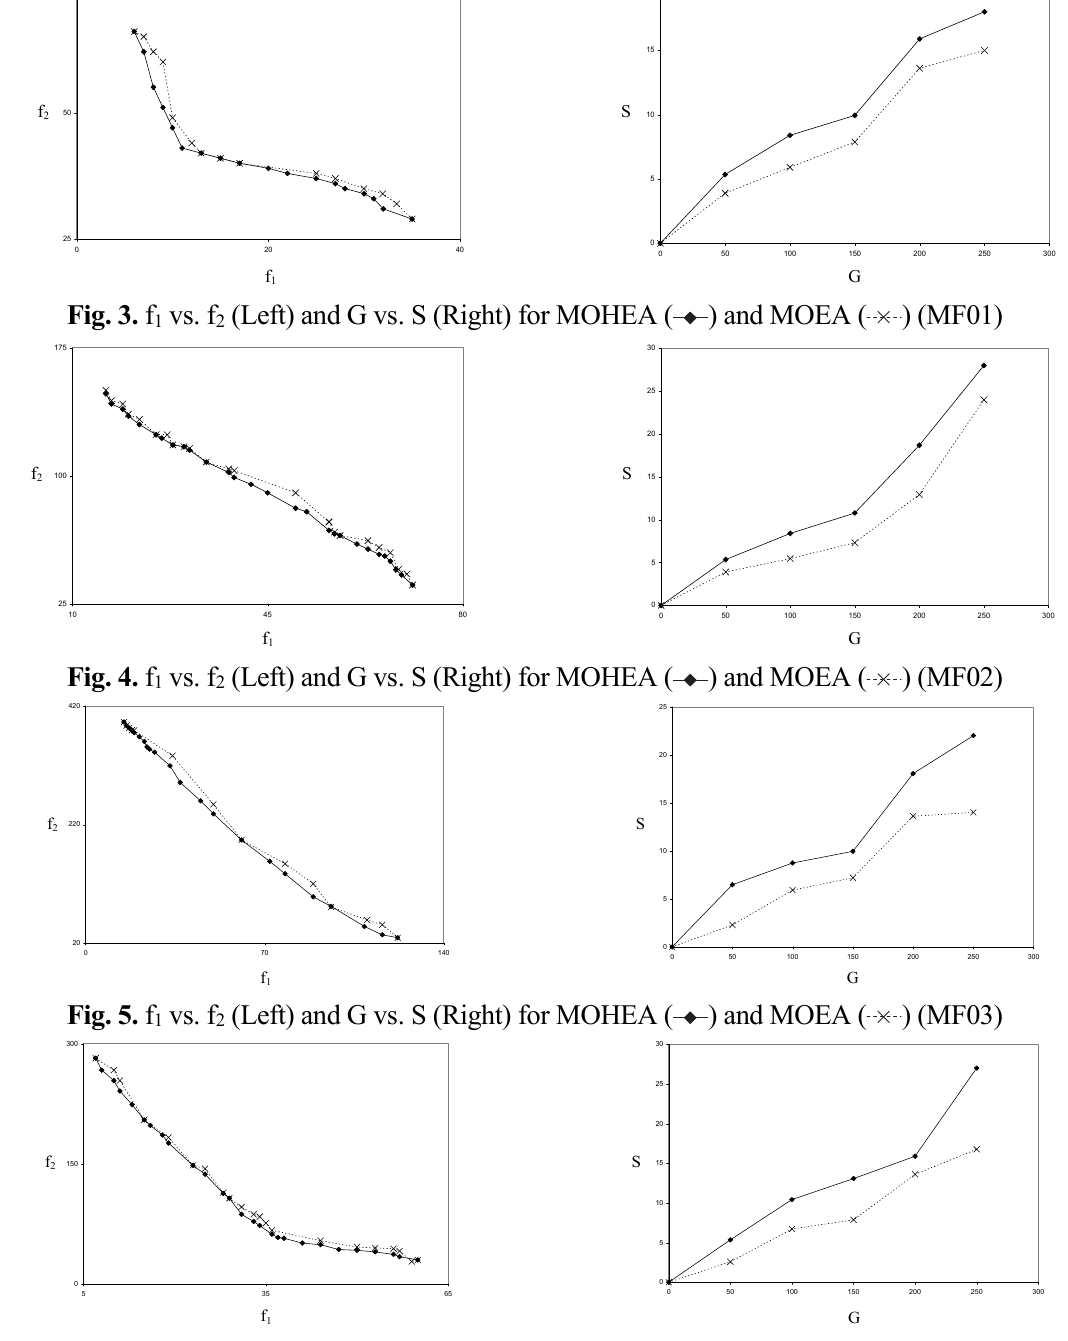
Fig. 6. f 1 vs. f 2 (Left) and G vs. S (Right) for MOHEA ( ) and MOEA ( )